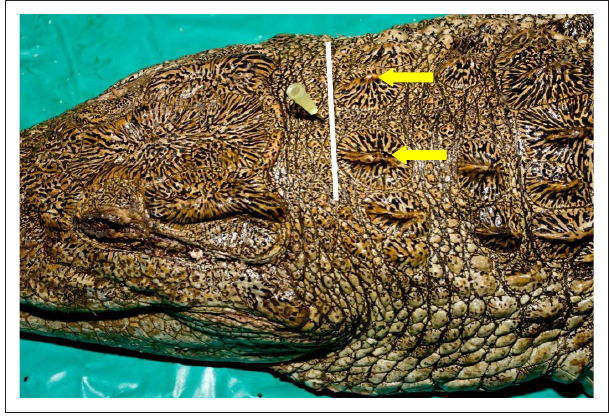
FIGURE 5: Needle placement for accessing the post-occipital spinal venous sinus demonstrated on a carcass received for necropsy.